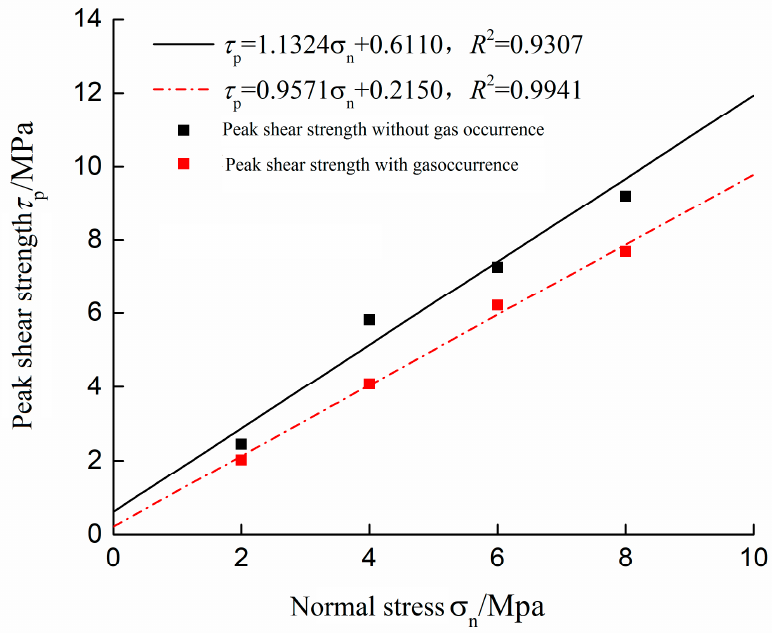
Figure 9. Fitting of shear strength of rock fracture with and without gas occurrence.